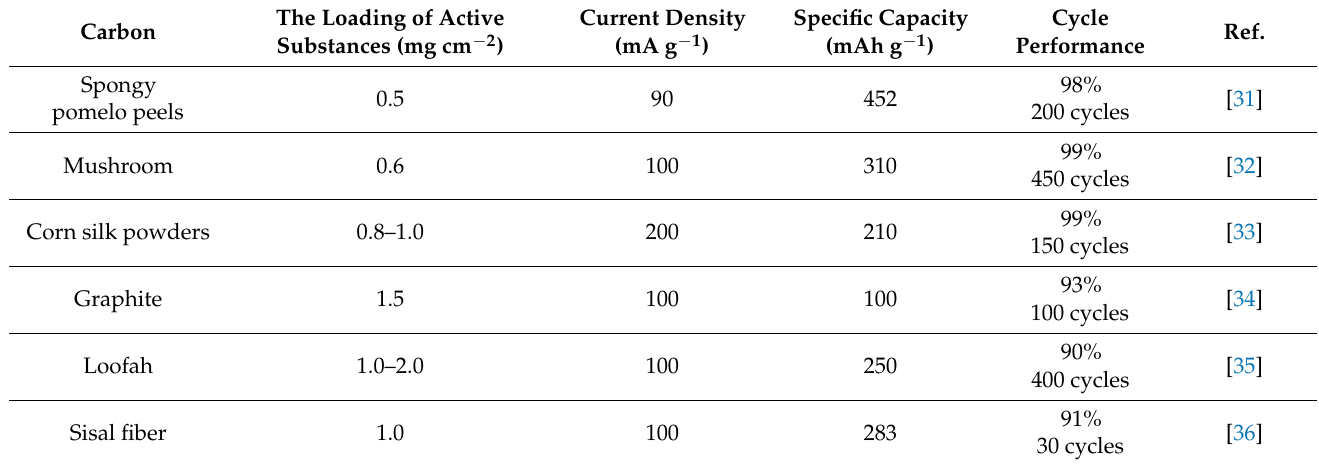
Figure 6. ( a , b ) Cycling performances and coulombic efficiency of CLN and CLMN at current density of 100 mA g − 1 ; ( c , d ) cycling performances and Coulombic efficiency of CLN and CLMN at current density of 1000 mA g − 1 . Table 1. A comparison of performance of porous carbon anodes reported in references.